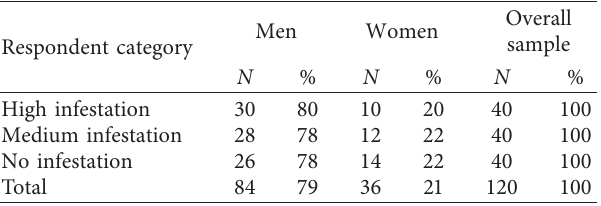
Figure 1: Map of the surveyed districts in the 2019 cropping Table 1: Sample size in the Striga-focused areas of the east and west Hararghe zones in the 2019 cropping season.